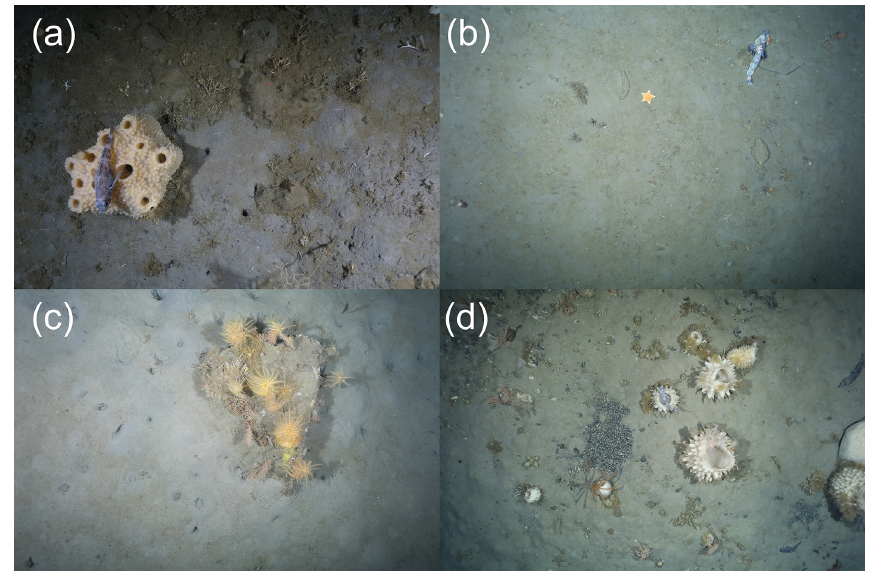
Figure 6. Typical seafloor images collected from each of the OFOBS surveys made of the eastern Filchner Shelf seafloor dur- ing RV Polarstern cruise 124. (a) Station PS124_8_1, HOTKEY_2021_02_12 at 04_27_23 IMG_0081.JPG, (b) Station PS124_16- 08, HOTKEY_2021_02_15 at 01_40_22 IMG_0567.JPG, (c) Station PS124_68-5, TIMER_2021_03_01 at 02_19_28.IMG, (d) Station PS124_107-05, TIMER_2021_03_12 at 02_17_42 IMG_0032.JG. The three red points within each image represent the sizing lasers (50cm spacing). All images are presented here and in the dataset with no manipulation or colour correction.